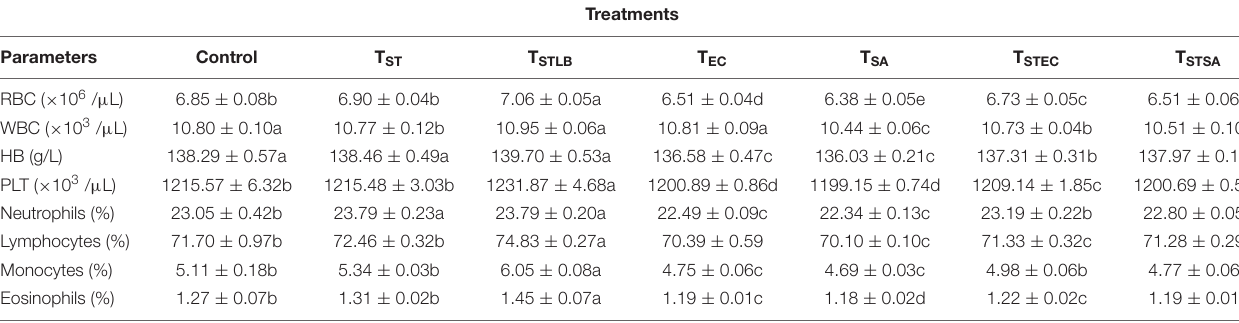
TABLE 3 | Hematological parameters of study animals after oral administration of S. thermophilus KLDS 3.1003 for 14 days.